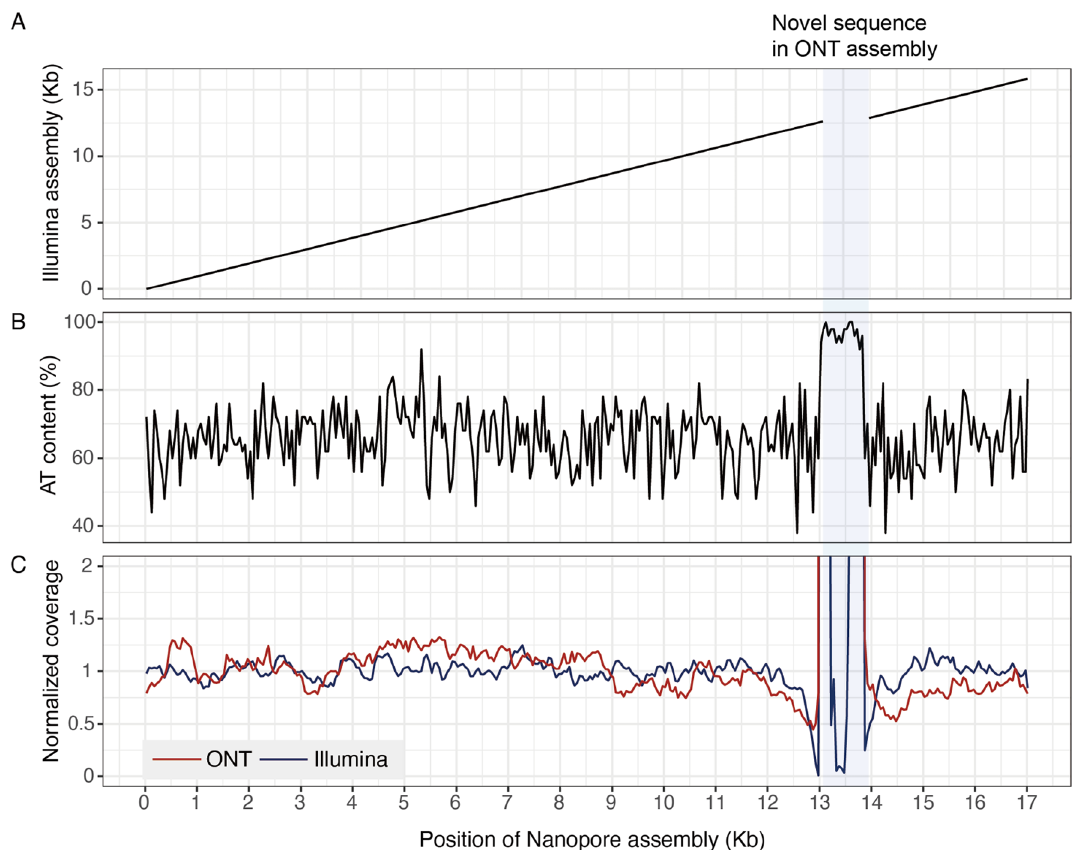
Figure 2. ONT assembly features of sample Mku. ( A ) Dotplot against Illumina assembly. ( B ) AT content in 50 bp windows. ( C ) Nanopore and Illumina read coverage in 50 bp